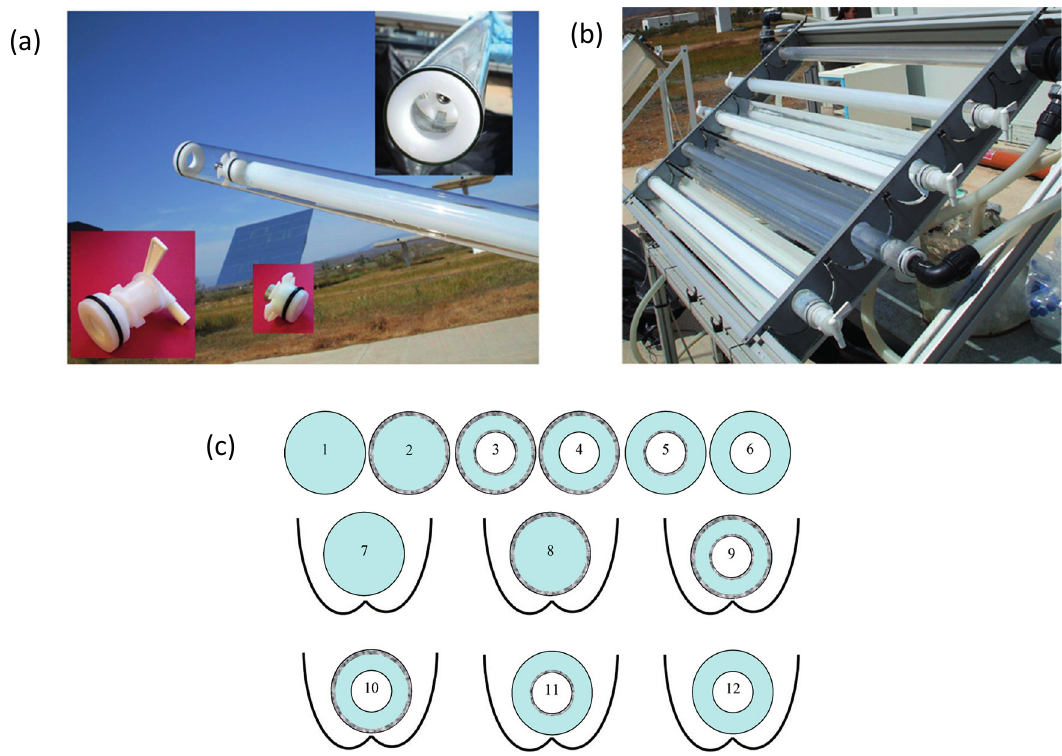
Figure 4. Photographs showing the double tube configuration with internal tube cap and the valve for external tube ( a ) and the solar photocatalytic reactor with and without CPC during disinfection tests ( b ). Schematic cross-section representation of the different reactor configurations tested in the solar reactor ( c ), (1)/(7) uncoated single tube without/with CPC; (2)/(8) coated single tube without/with CPC; (3)/(9) coated double tube without/with CPC; (4)/(10) coated external–uncoated internal without/with CPC; (5)/(11) coated internal–uncoated external without/with CPC; (6)/(12) uncoated double tube without/with CPC